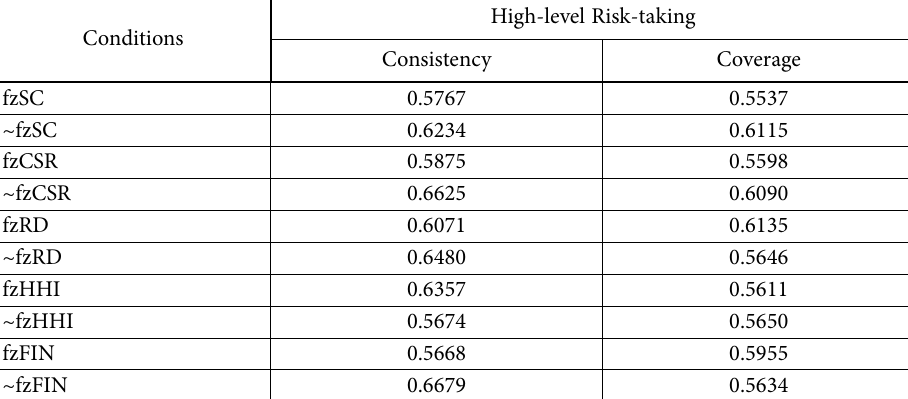
Table 2. Analysis of necessary